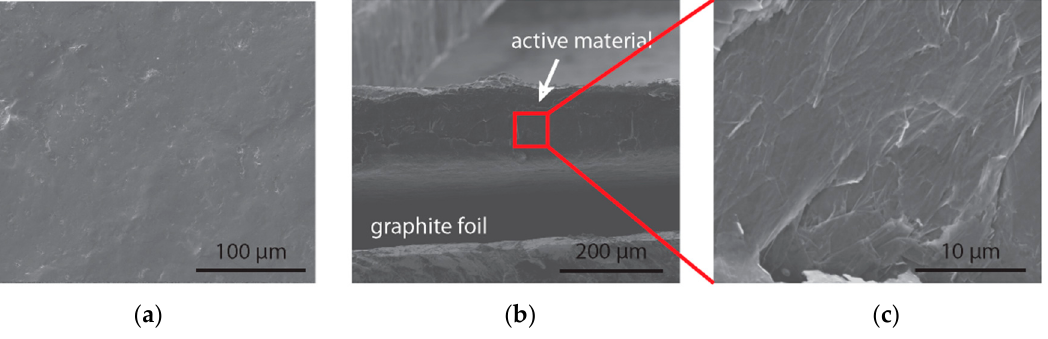
Figure 4. Scanning electron microscope (SEM) image of fabricated aniline tetramer and graphene oxide composite electrode: ( a ) top view; ( b ) cross-section of composite on current collector graphite foil; ( c ) expanded view of cross-section.